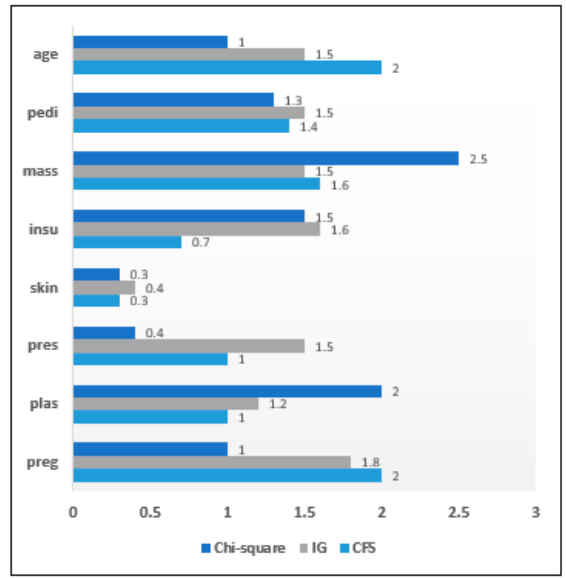
Figure 7. Attribute Significance Graph for the Diabetes dataset with Filters. Appl. Sci. 2020 , 10 , x FOR PEER REVIEW